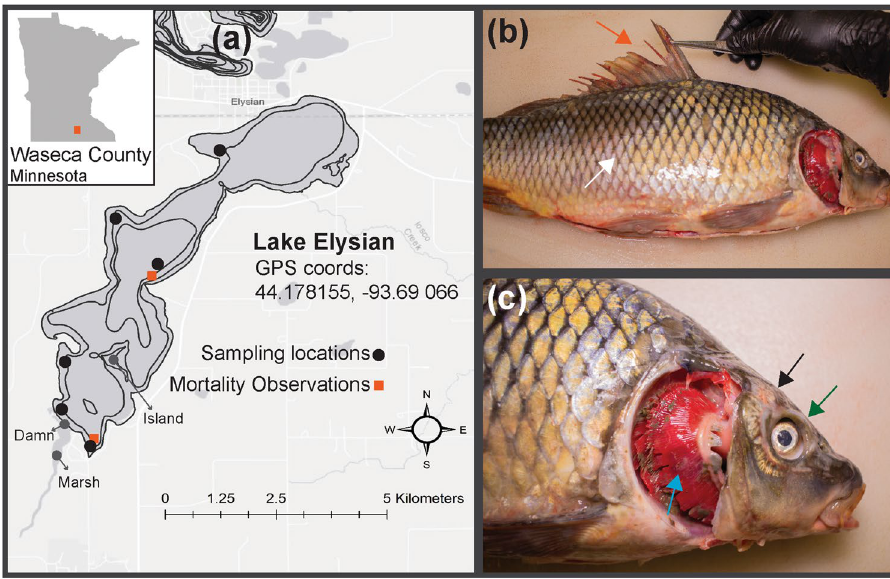
Figure 1. ( a ) Generated using ArcMap (v10.8.1, https ://deskt op.arcgi s.com/en/arcma p/), shows the approximate locations of sampling effort and mortality observations on Lake Elysian. Bathymetric contours indicate depth in 5 ft increments. ( b , c ) Pathology of a representative individual wild carp sampled from Lake Elysian. Arrows on ( b , c ) denote frayed fins (vermillion), loss of mucosal layer (white), loss of scales and epidermis (black), enopthalmia (bluish green), gill necrosis (sky